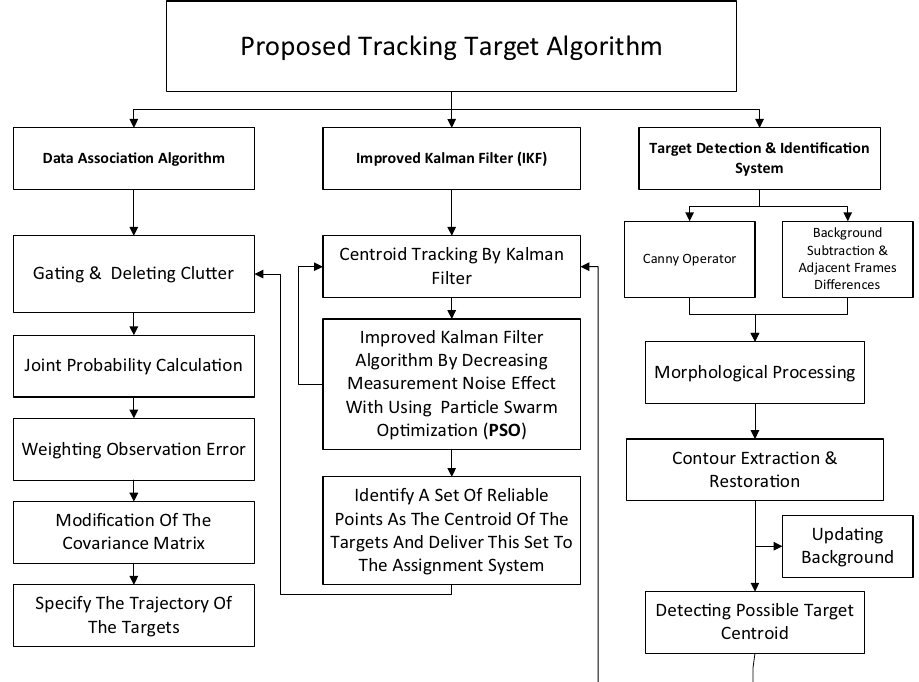
Proposed Tracking Target